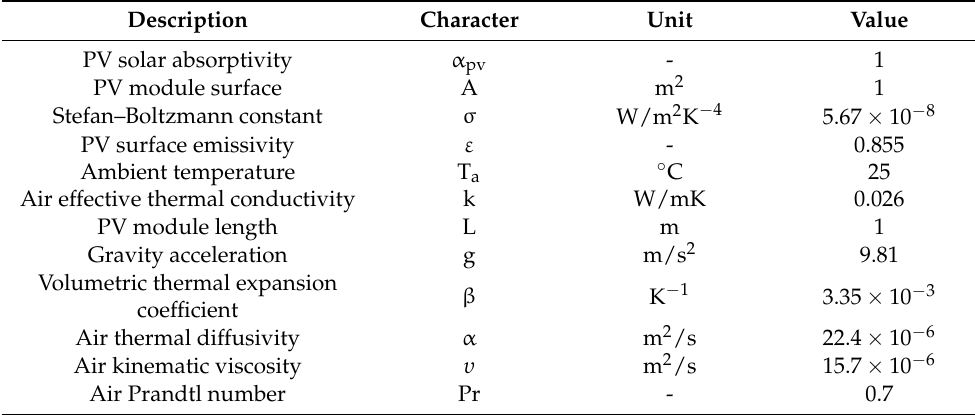
Table 1. Variables and constants taken from [1] used in the numerical